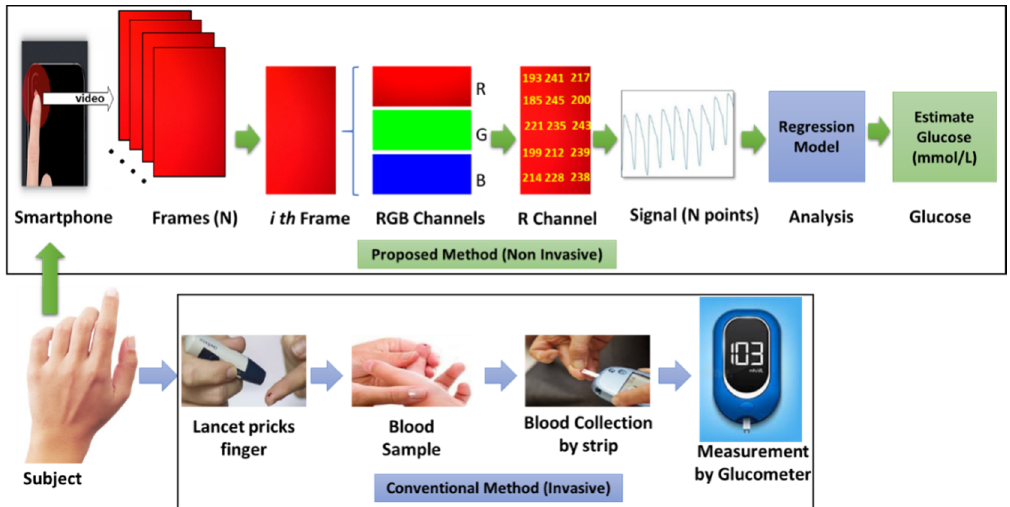
Figure 1. System diagram of noninvasive glucose detection using smartphone camera ( top ) compared with the conventional glucometer-based technique ( bottom ).